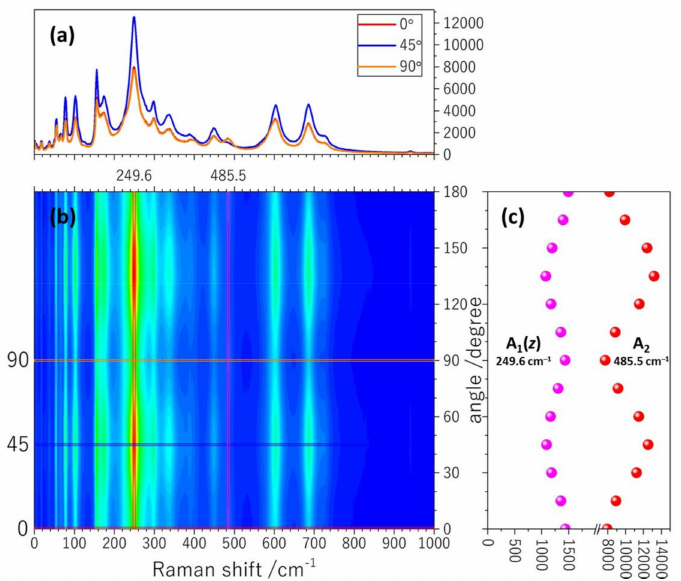
Figure 5. ( a ) Raman spectra in parallel nicol geometries obtained in a spectral range from 0 to 1000 cm − 1 ; ( b ) Contour plots of angular dependences of the polarized Raman intensity; ( c ) Angular dependence of the integrated Raman intensities of the modes at 249.6 cm − 1 and 485.5 cm − 1 indicated by vertical red and pink lines in ( c ). These modes are assigned to be A 1 ( z ) and A 2 modes